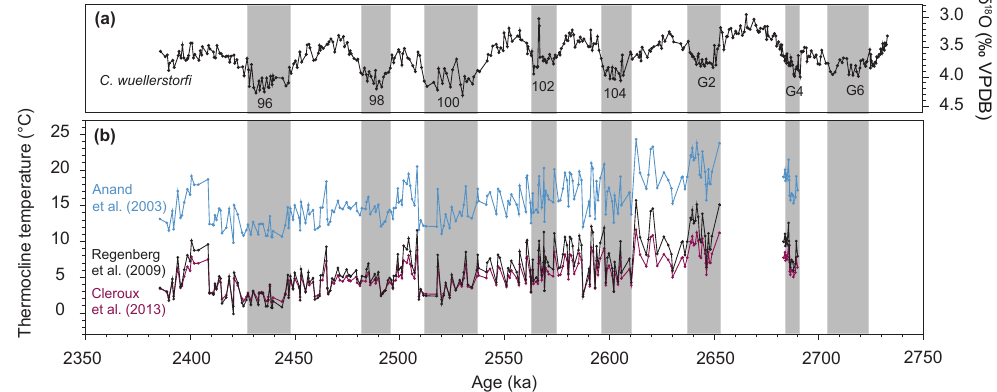
Figure 2. Species-specific conversions of Mg / Ca ratios to temperature for G. crassaformis . (a) Benthic foraminiferal ( C. wuellerstorfi ) δ 18 O stratigraphy (Jakob et al., 2017). (b) Comparison of the different species-specific Mg / Ca to temperature conversions of Cléroux et al. (2013; red), Regenberg et al. (2009; black) and Anand et al. (2003; blue) applied to G. crassaformis Mg / Ca values from Site 849 for ∼ 2 . 75 to 2.4Ma. Gaps in the dataset for 2.68–2.65Ma (MIS G3) and 2.73–2.69Ma (MIS G7–G5) are due to a lack of G. crassaformis specimens in the investigated size fraction (315–400µm). Grey bars highlight glacial